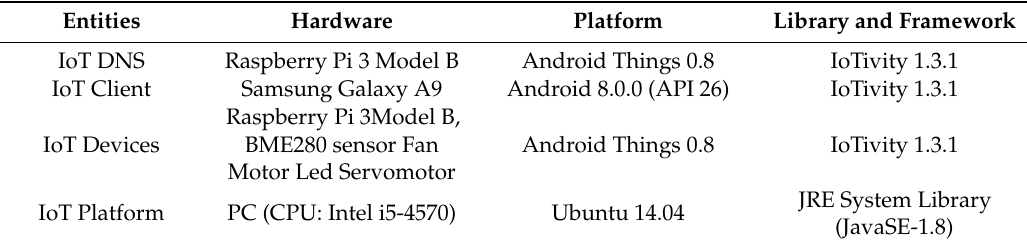
Table 1. Implementation environment.